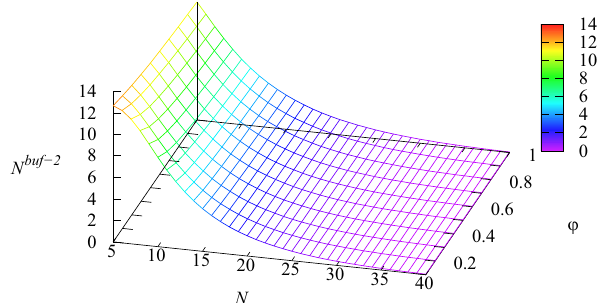
Figure 5. Dependence of the mean number of requests N buf − 2 in the second buffer on ϕ and N